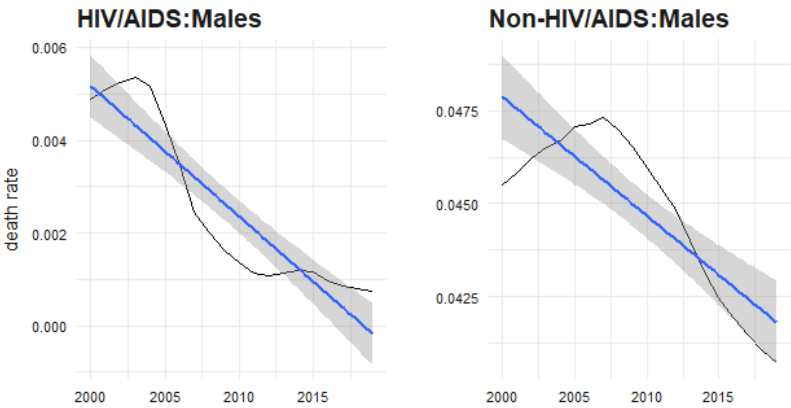
Figure 1. HIV/AIDS and non-HIV/AIDS distribution for males over time given by the black line (observed trend plot) and the blue line (fitted abline).